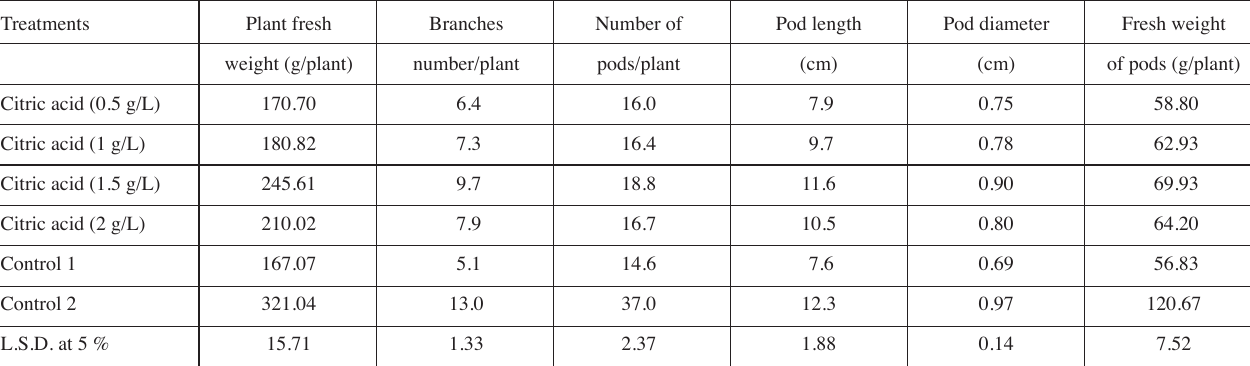
Tab. 2: Effect of different levels of citric acid on vegetative growth, generative productivity and pod characteristics of bean plants subjected to drought stress conditions (second season). Control 1: plants not treated by citric acid, but stressed. Control 2: plants not treated by citric acid and kept at field capacity during the entire experiments.